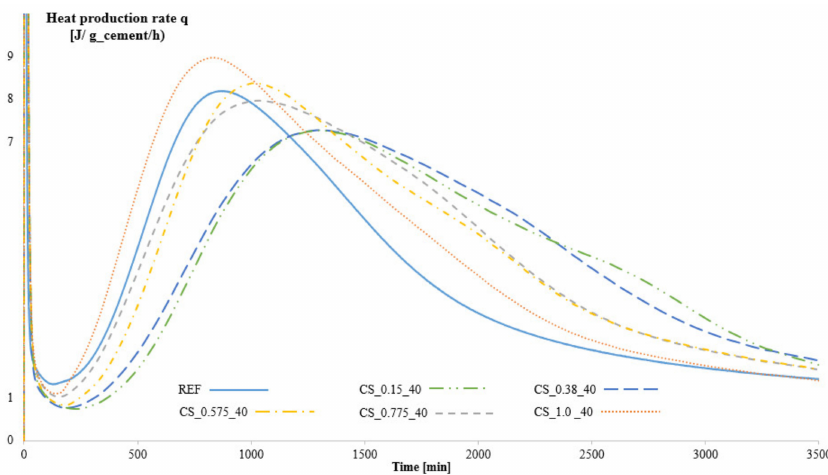
Figure 3. Hydration kinetics of the reference mixture and the mixtures containing SAPs with di ff erent amounts of cross-linker, Series